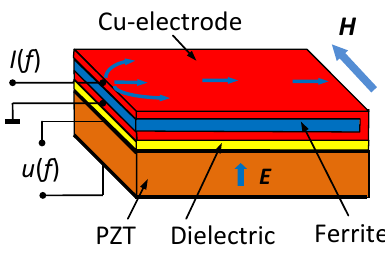
Figure 22. Schematic view of a Cu/NZFO/Cu-PZT heterostructure with integrated excitation system. The arrows show directions of electric E and magnetic H fields.